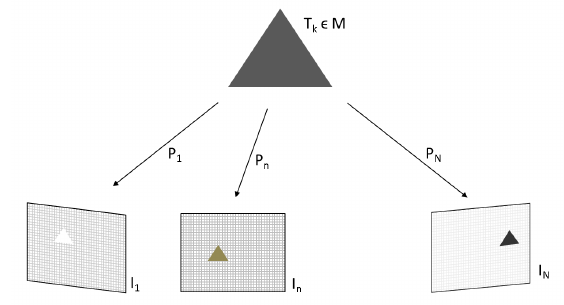
Figure 2. Sketch of a scene with a reconstructed mesh repre- sented by triangle T k ∈ M and three views. The brightness of the projected triangle varies in all three images from white ( I 1 ) to black ( I N